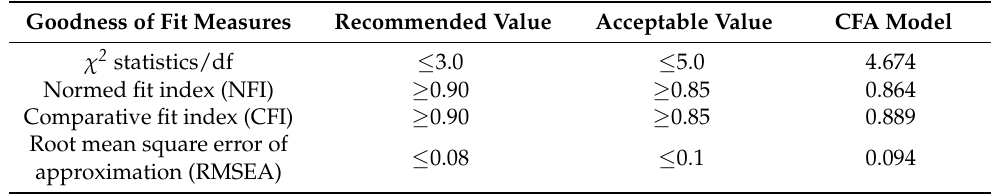
Table 8. Goodness of fit- CFA model.